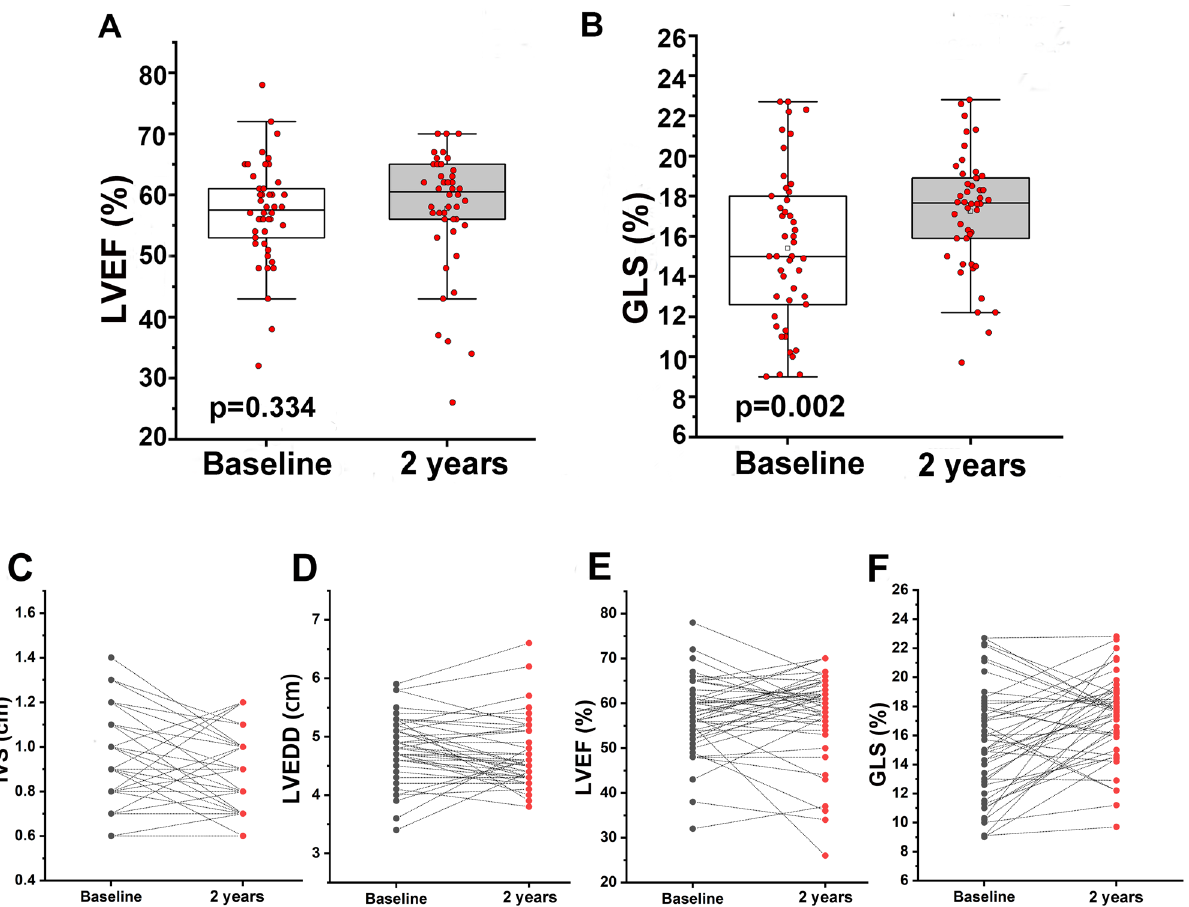
57.74 ± 9.82, p = 0.334). Individual changes of IVS, LVEDD, LVEF and GLS at discharge and at 2-year were also shown ( C – F ). http://m. qpic. cn/ psc?/ V53wp KJ24F 3mOO0 15TIE 1dJF3 728Qw lj/ ruAMs a53pV QWN7F LK88i 5oJoe 1CbnG P7nop AtC78 vvMNd P5Hrs P7pgz *HPB8q e4QGV WxGDy 1Y838 JPaEn pWfjq vykTm C9ptG fPrfQ Bxtje o!/ mnull & bo= gAdAB oAHQA YBByA !& rf= photo